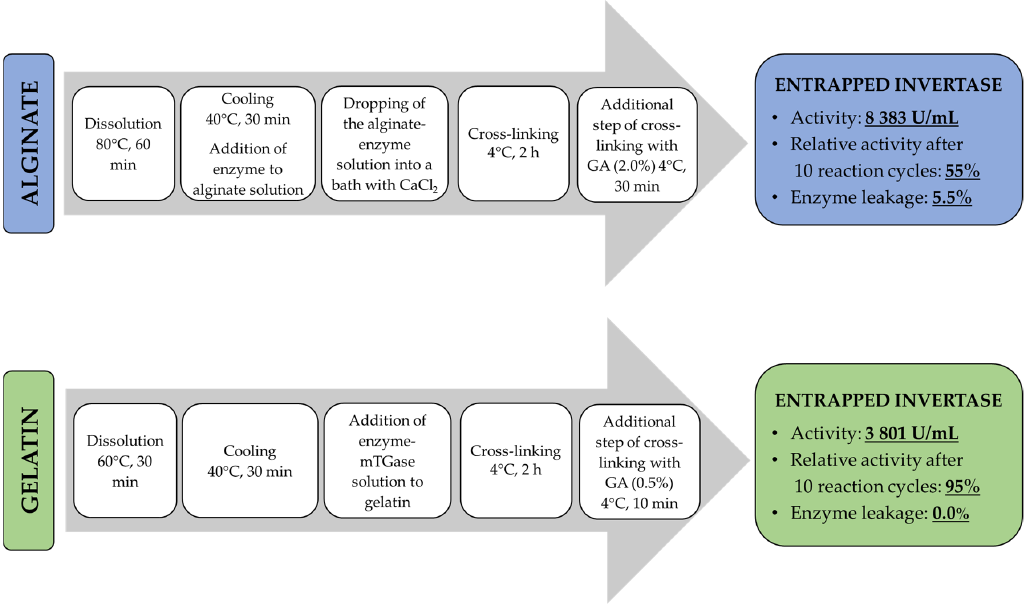
Figure 11. Comparison of the entrapment procedures of invertase in alginate and gelatin-based Comparison of the entrapment procedures of invertase in alginate and gelatin- hydrogels. based hydrogels.